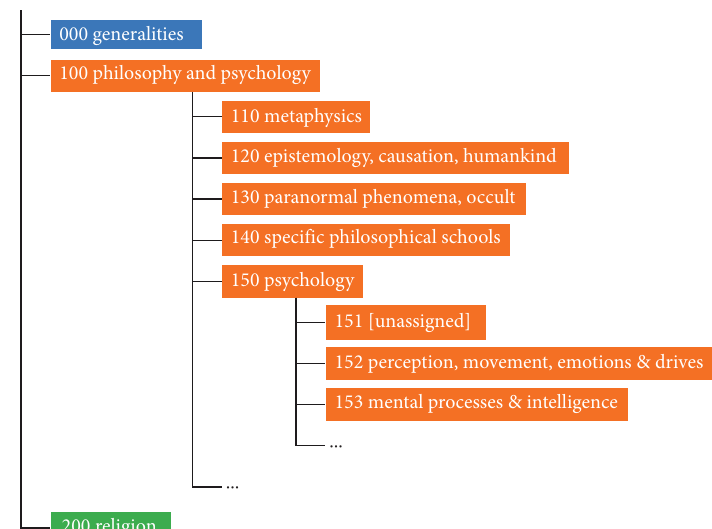
Figure 15: A subtree of the DDC displaying a snapshot of the second class (100) on the first three